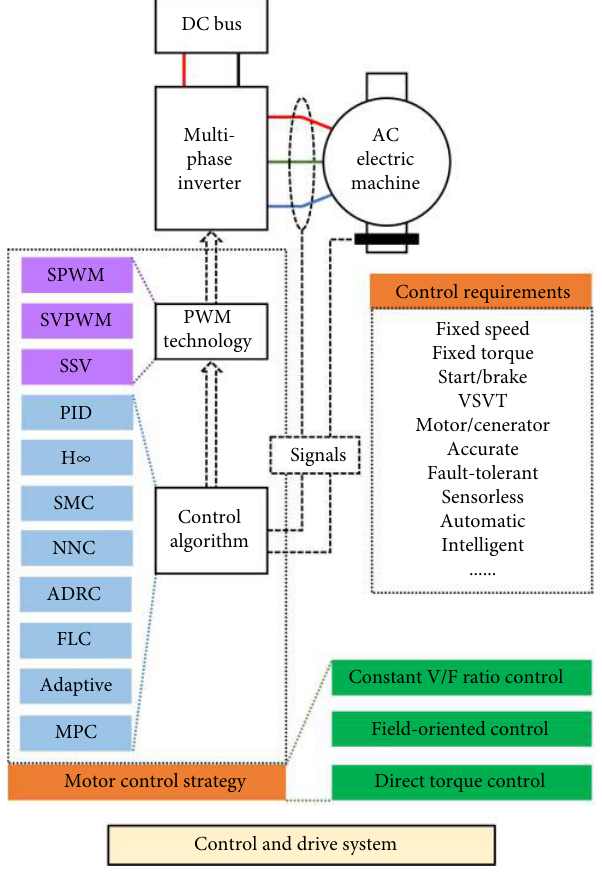
Fig. 22 Diagram of control and drive system.